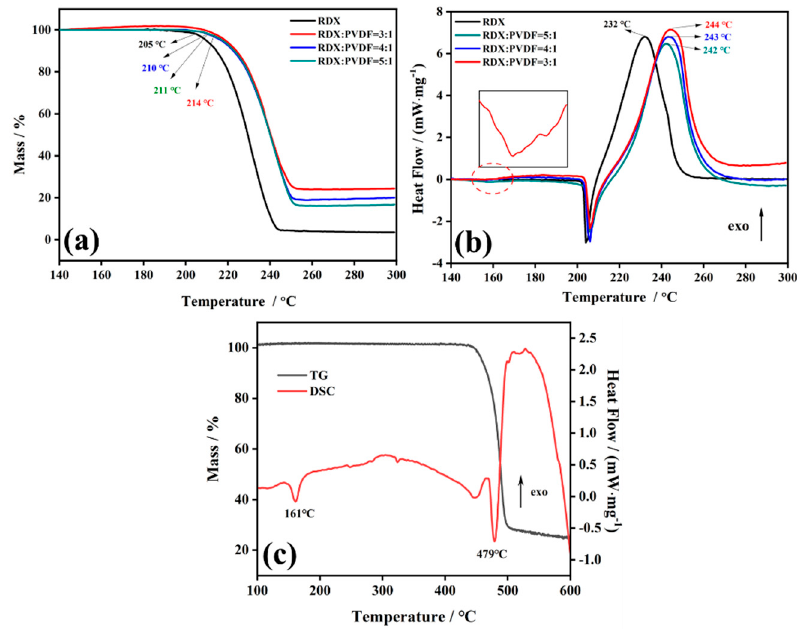
Figure 7. TGA/DSC of RDX@PVDF microspheres at 10 K/min: ( a ) TG curves of raw RDX and RDX@PVDF; ( b ) DSC curves of raw RDX and RDX@PVDF; and ( c ) TG-DSC curves of PVDF.